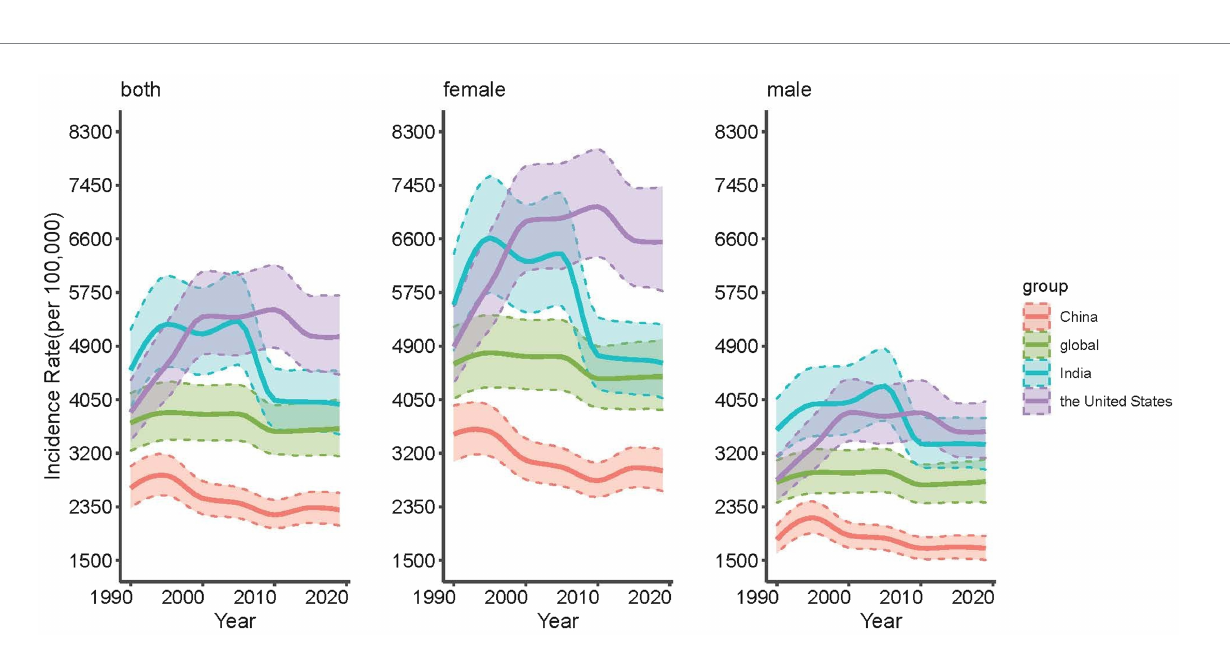
FIGURE 2 Trends of age-standardized incidence rates for depressive disorders in the whole population, males and females in China, the United States, India and the global, 1990 to